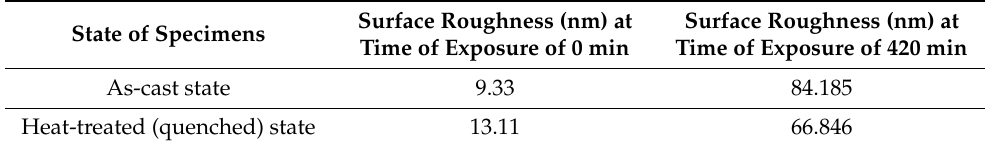
Table 4. Values of surface roughness of the samples in the different state and at different times of exposure to cavitation